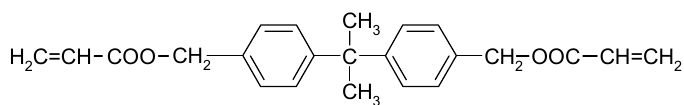
Figure 1. Structure of the diacrylate